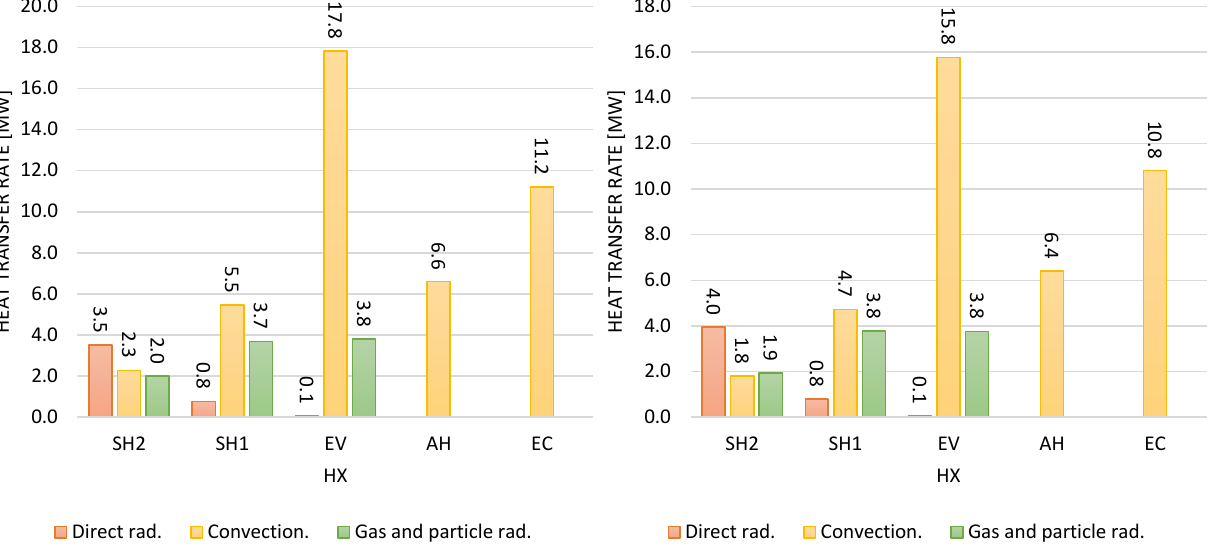
Figure 14. Calculated and measured heat transfer rates per heat exchanger component for indus- trial-scale biomass-fired boiler 65% load case.